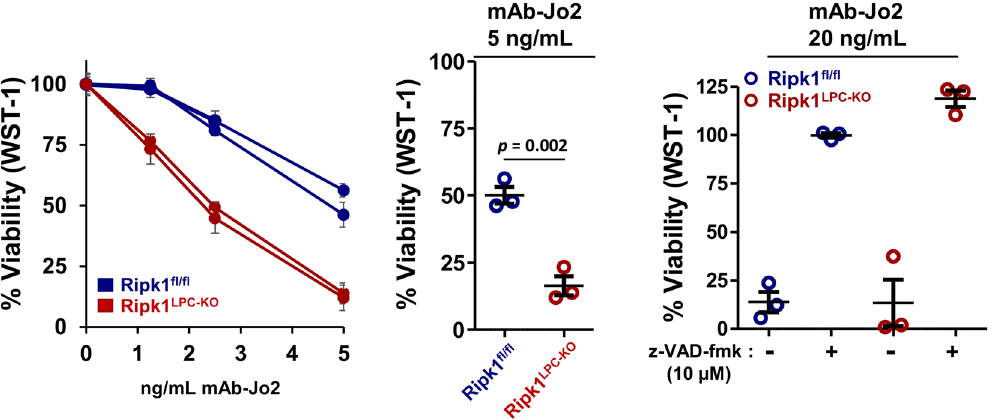
Figure 4. RIPK1 deficiency increases the sensitivity of primary hepatocytes to Fas-agonist stimulation. Primary cultures of hepatocytes issued from Ripk1 fl/fl ( n = 2) or Ripk1 LPC-KO (n = 2) mice were subjected during 16 h to mAb-Jo2 concentrations ranging from 1 to 5 ng/mL in presence of ETA (1 µ g/mL) (left panel). Additional primary cultures (n = 3 for each strains) were exposed to a unique dose of mAb-Jo2 (5 ng/mL) also in